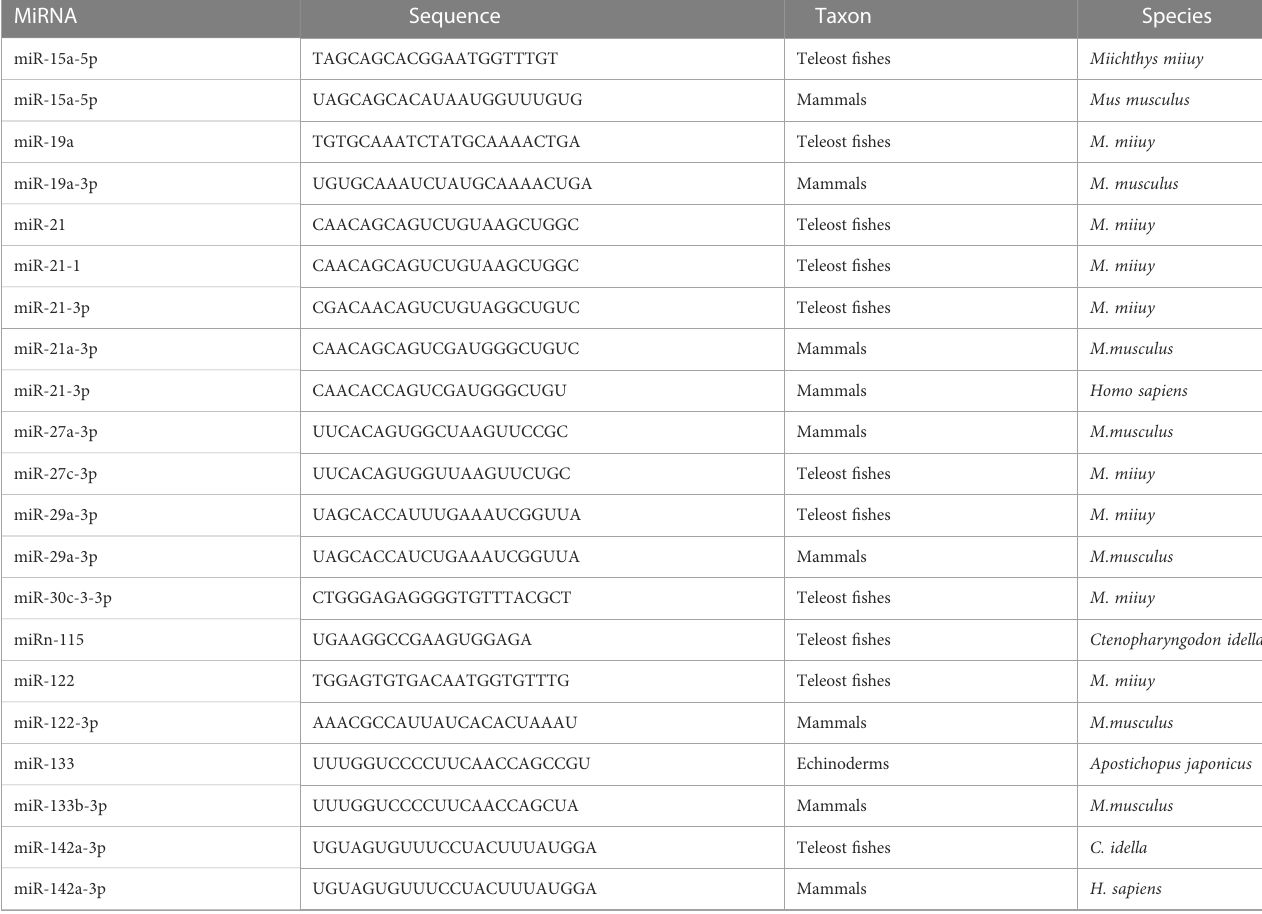
TABLE 4 microRNAs (miRNAs) sequences used for phylogenetic analysis.